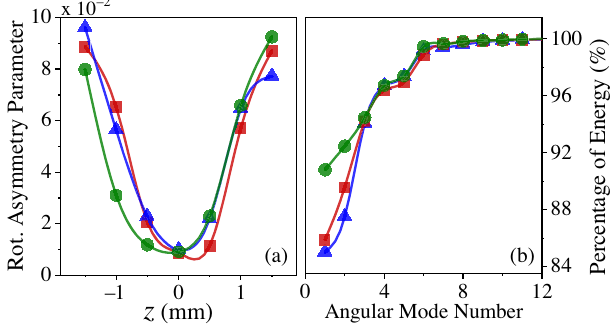
FIG. 3. (a) Rotational asymmetry parameter through focus for the three experimental laser energy distributions shown in Fig. 2; (b) Cumulative fraction of energy contained in successive angular modes in the simulated laser distributions. For both (a) and (b), FPS, 1bFPS, and 2bFPS are displayed in red squares, blue triangles, and green circles,